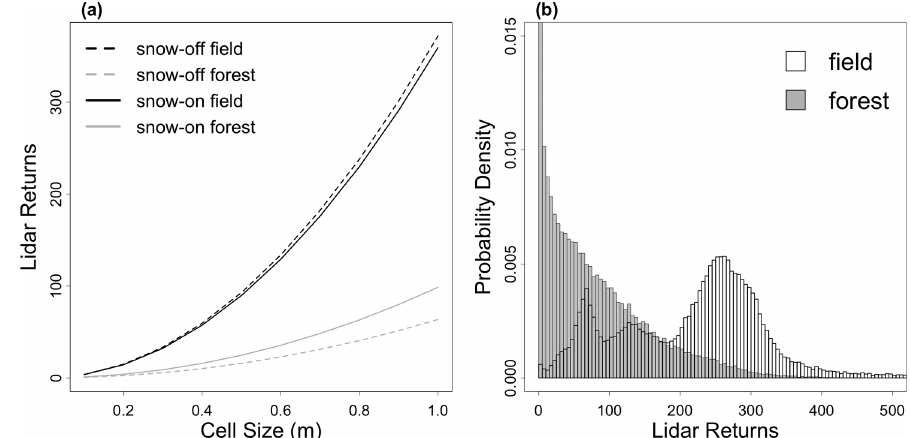
Figure 2. (a) Average lidar point cloud density of the ground returns versus cell size by land cover and snow-on and snow-off state. (b) Prob- ability density function for the number of lidar ground returns by square meter for the forest (gray) and the field (white).